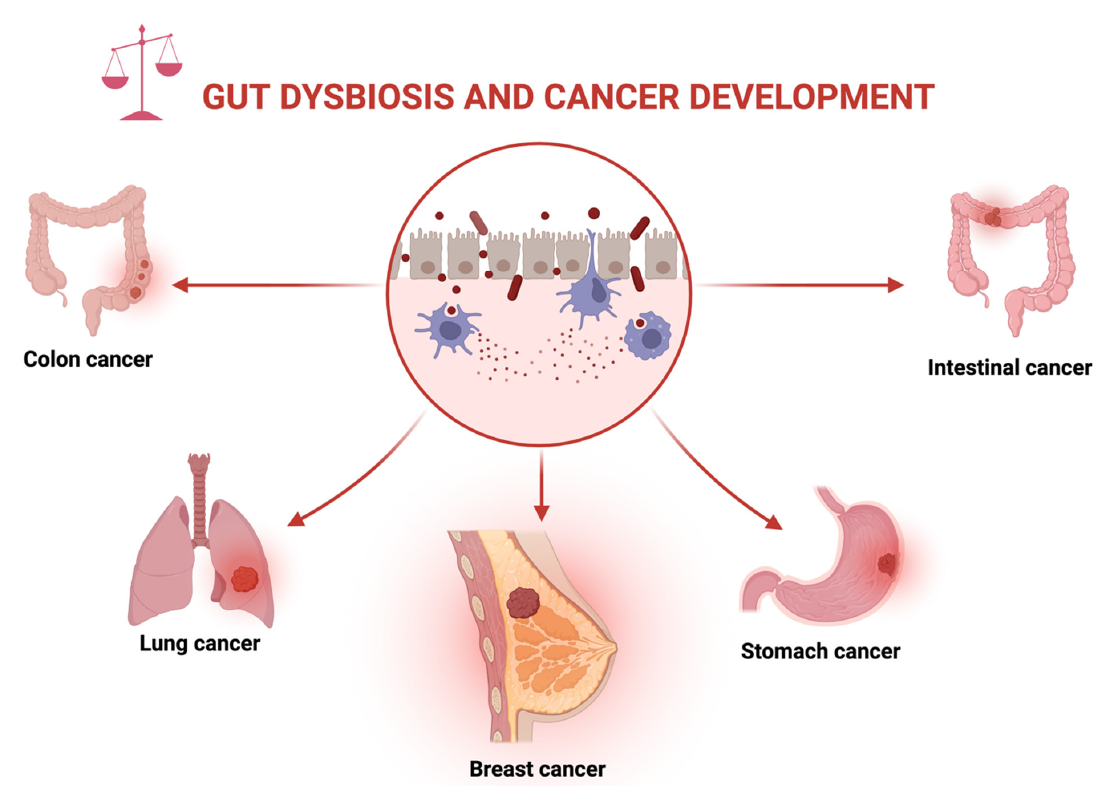
Figure 1. Dysbiosis (imbalance of the health gut microbial population) can lead to the development of different cancer types, including breast, colon, lung, stomach, and intestinal cancers.